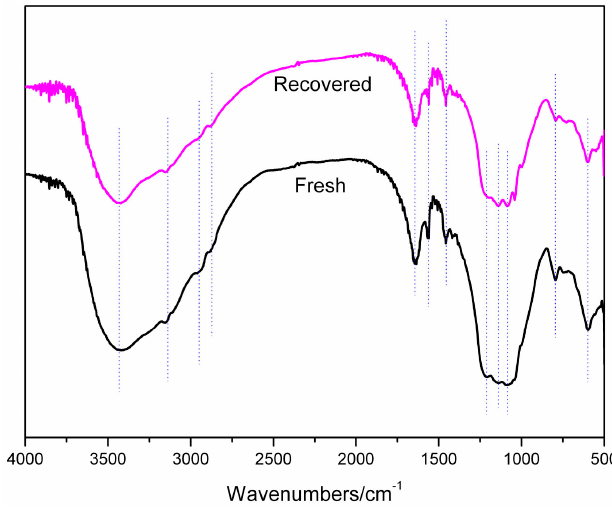
Figure 1. Recycling experiment of AIL@MNP.